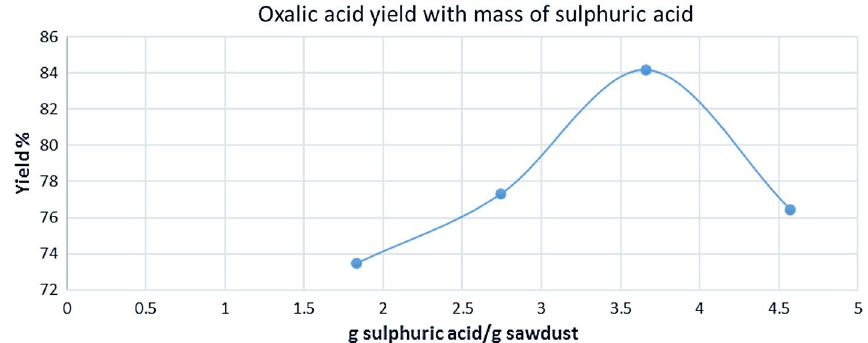
Fig. 2 Effect of the amount of H SO 2 4 used on the oxalic acid